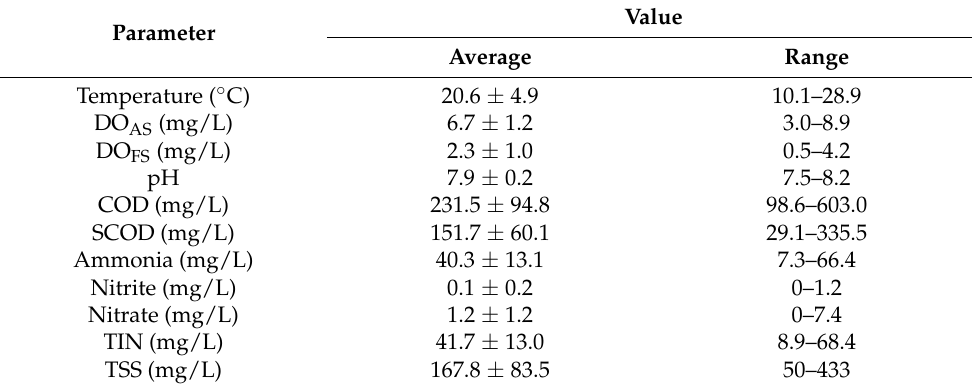
Table 1. Water quality characteristics of the original wastewater.